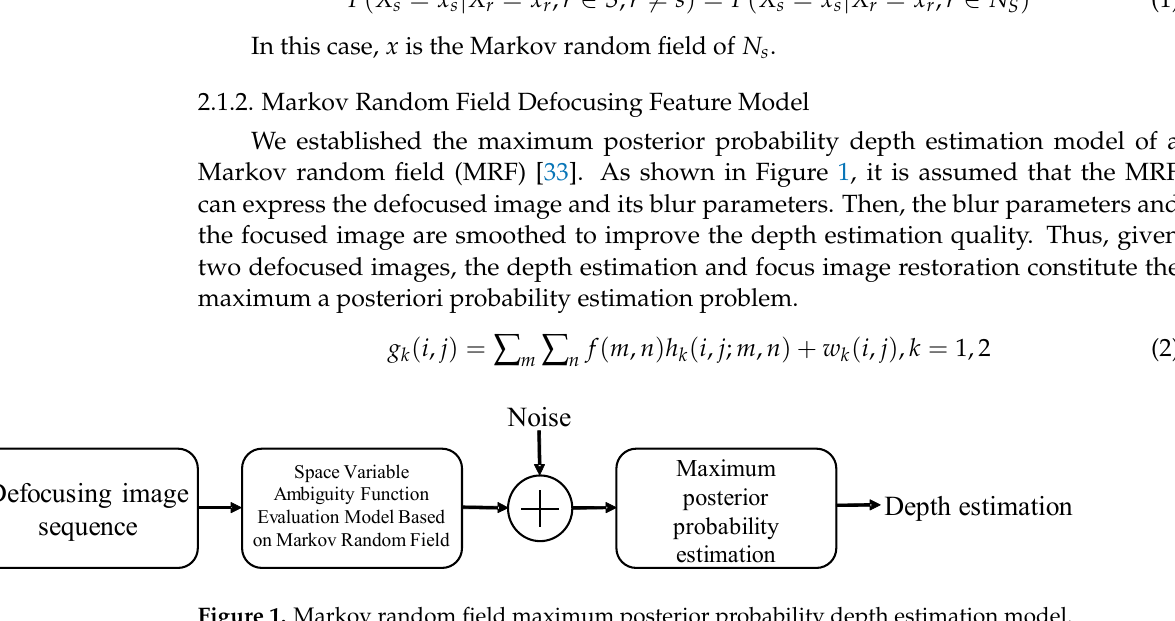
Figure 1. Markov random field maximum posterior probability depth estimation model. 𝑔 (⋅) and 𝑔 (⋅) represents two defocused images, the original focus image 𝑓(⋅) is (cid:2869) (cid:2870) (⋅) and ℎ (⋅) are gaussian model ambiguity unknown, and the ambiguity functions ℎ (cid:2869) (cid:2870) functions composed of blur parameters [34].